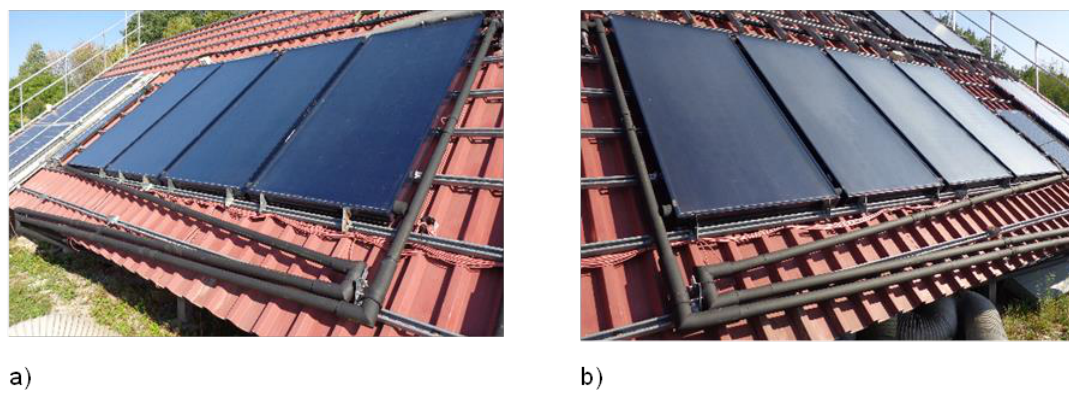
Figure 1. Array of four flat-plate collectors with ( a ) thermochromic absorbers and ( b ) standard selective absorbers.